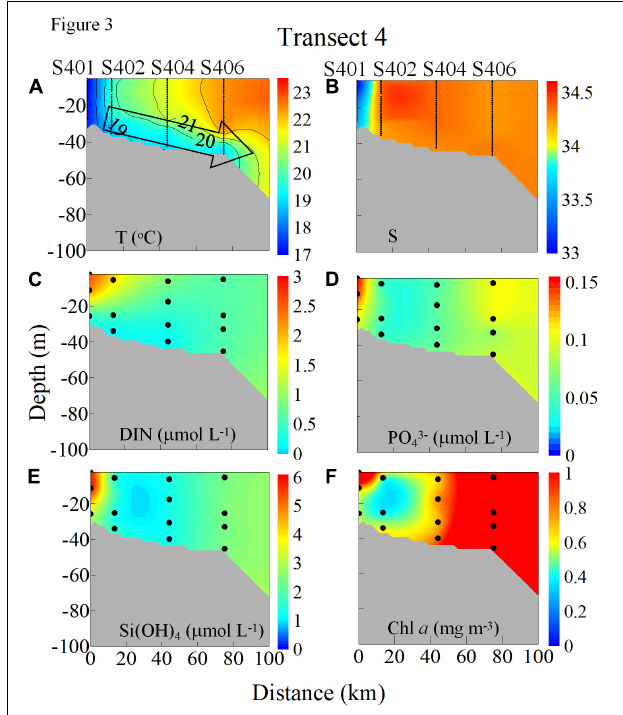
FIGURE 3 | Vertical distributions of (A) T ( ◦ C), (B) S , (C) DIN (NO 3 − + NO 2 − , µ mol L − 1 ), (D) PO 43 − ( µ mol L − 1 ), (E) Si(OH) 4 ( µ mol L − 1 ), and (F) Chl a (mg m − 3 ) along Transect 4 in the NSCS shelf in winter